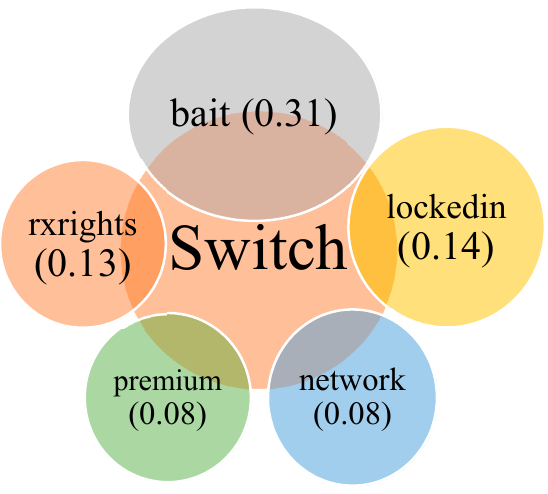
Figure 1. Word associations for plan attributes and switching among health insurance tweets.